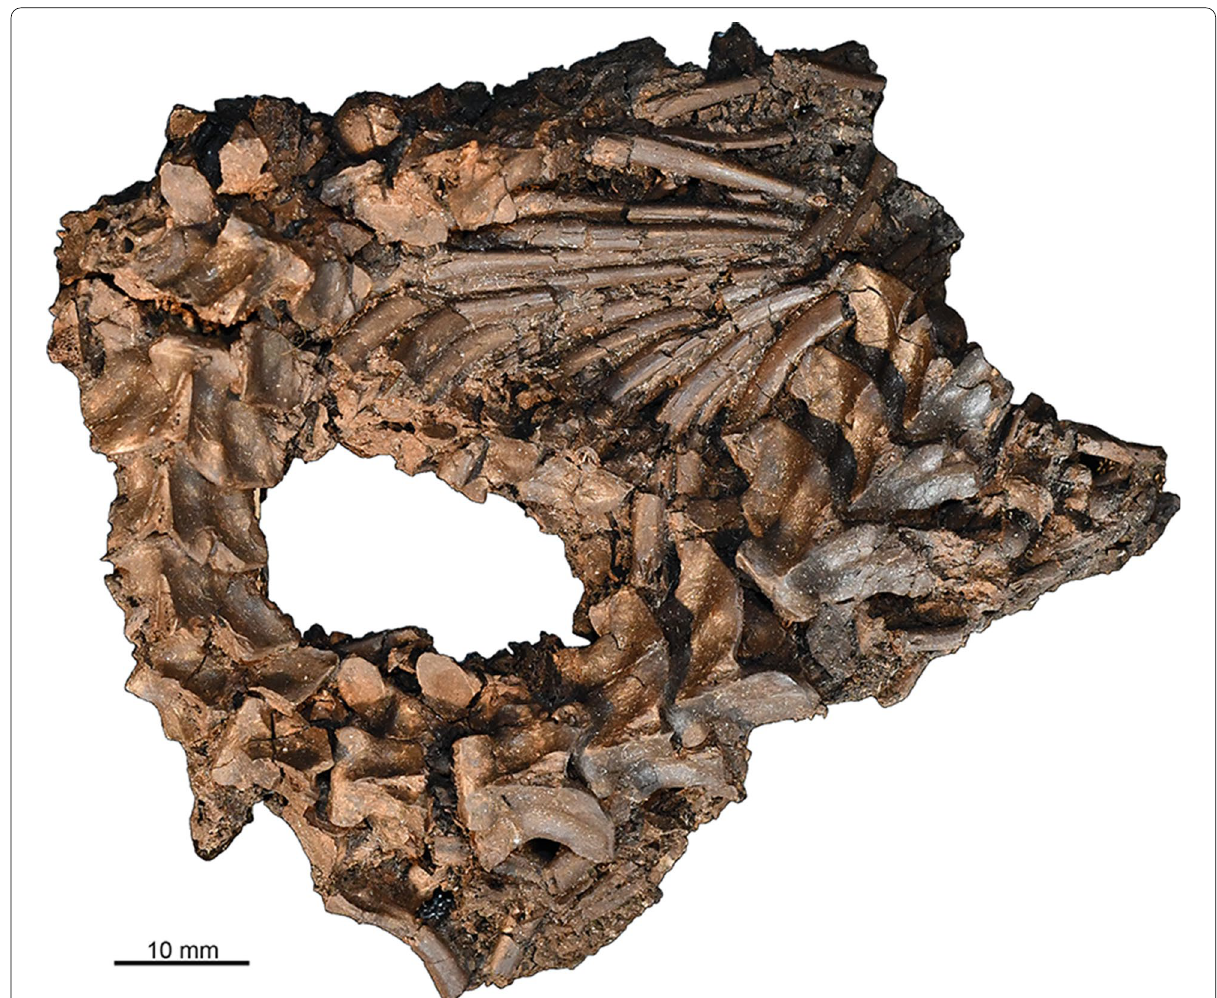
Fig. 60 Eoconstrictor cf. fischeri from quarry XXXVI, Geiseltal: string of several articulated trunk vertebrae and ribs (GMH